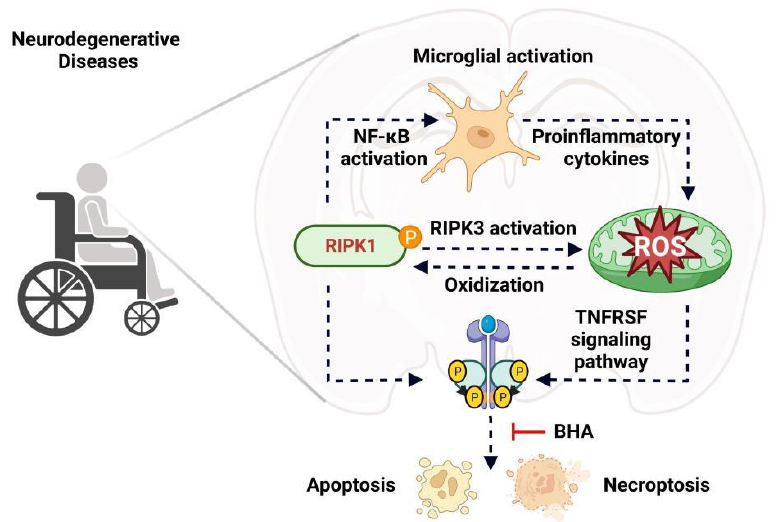
Figure 3. Activated RIPK1 and ROS generation enhance each other in a positive feedback loop. Excessive production of ROS activates RIPK downstream signaling pathways or directly oxidizes cysteine residues of RIPK1 to increase RIPK1 kinase activity. On the other hand, in neurodegenerative diseases, RIPK1 activation promotes ROS production via microglia-derived proinflammatory cytokines or activating RIPK3 that, in turn, phosphorylates the pyruvate dehydrogenase complex and increases ROS production. ROS